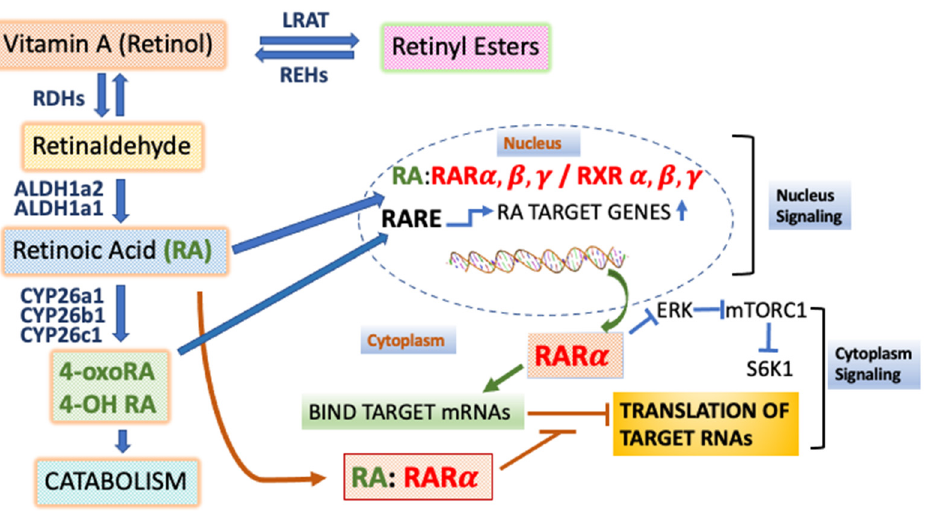
Figure 1. Model of Intracellular Retinol Metabolism and Molecular Actions. Retinoic acid (RA), the endogenous agonist for the three retinoic acid receptors (RAR α , β , and γ ), moves to the nucleus where it binds an RAR in a heterodimer with an RXR. This results in transcriptional activation of primary target genes that contain a retinoic acid response element (RARE) on DNA. A metabolite of RA, 4-OxoRA, can also act as an agonist for RARs. RAR α can move to the cytoplasm, actively transported out of the nucleus, where RAR α can regulate the rate of translation of target mRNAs into proteins, with different effects if the ligand RA is bound to RAR α . RAR α , without the ligand RA, can also inhibit ERK and mTORC1 signaling. The cytoplasmic actions of RAR α have only been shown to date in neurons. Abbreviations: RDHs: retinol dehydrogenases; ALDH: aldehyde dehy- drogenase; CYP26: Cytochrome P450 family 26 subfamily A member 1; ERK: extracellular signal- regulated kinase; mTORC1: mammalian target of rapamycin complex 1; LRAT: lecithin retinol acyl- transferase; REH: retinyl ester hydrolase; S6K1: 40S ribosomal protein S6 kinase p70/p85.